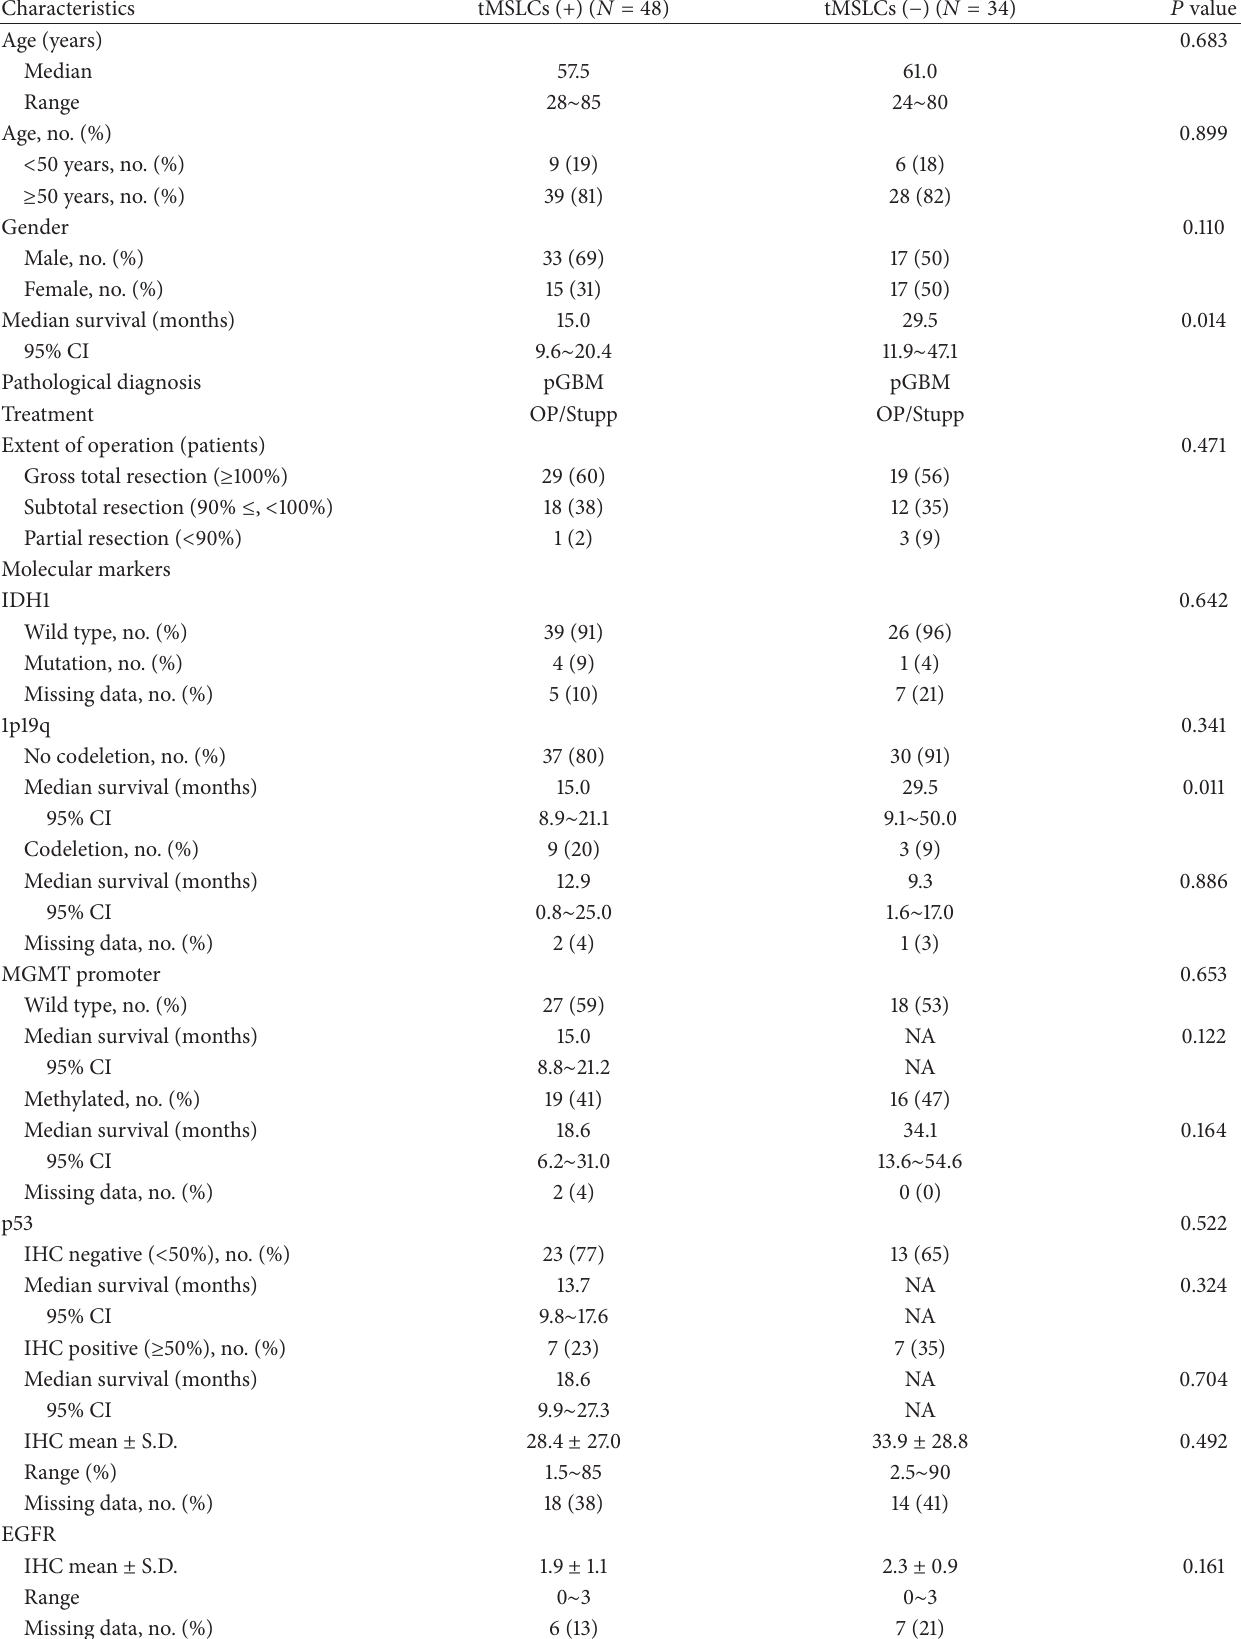
Table 1: Demographic and clinical characteristics of patients with